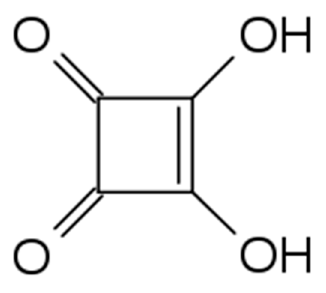
Figure 1. Chemical structure of squaric acid (H 2 SQ).